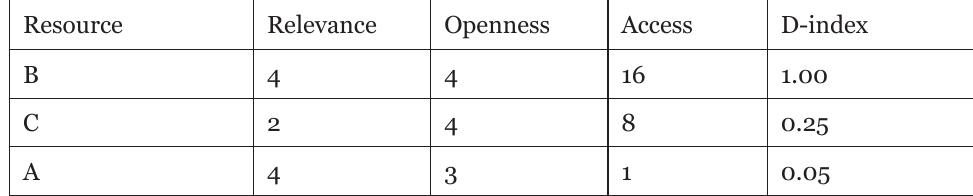
After Applying the D-index to the Same Search Results Shown in Table 5